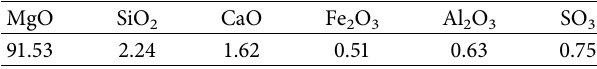
Table 1: Chemical composition of magnesium oxide.